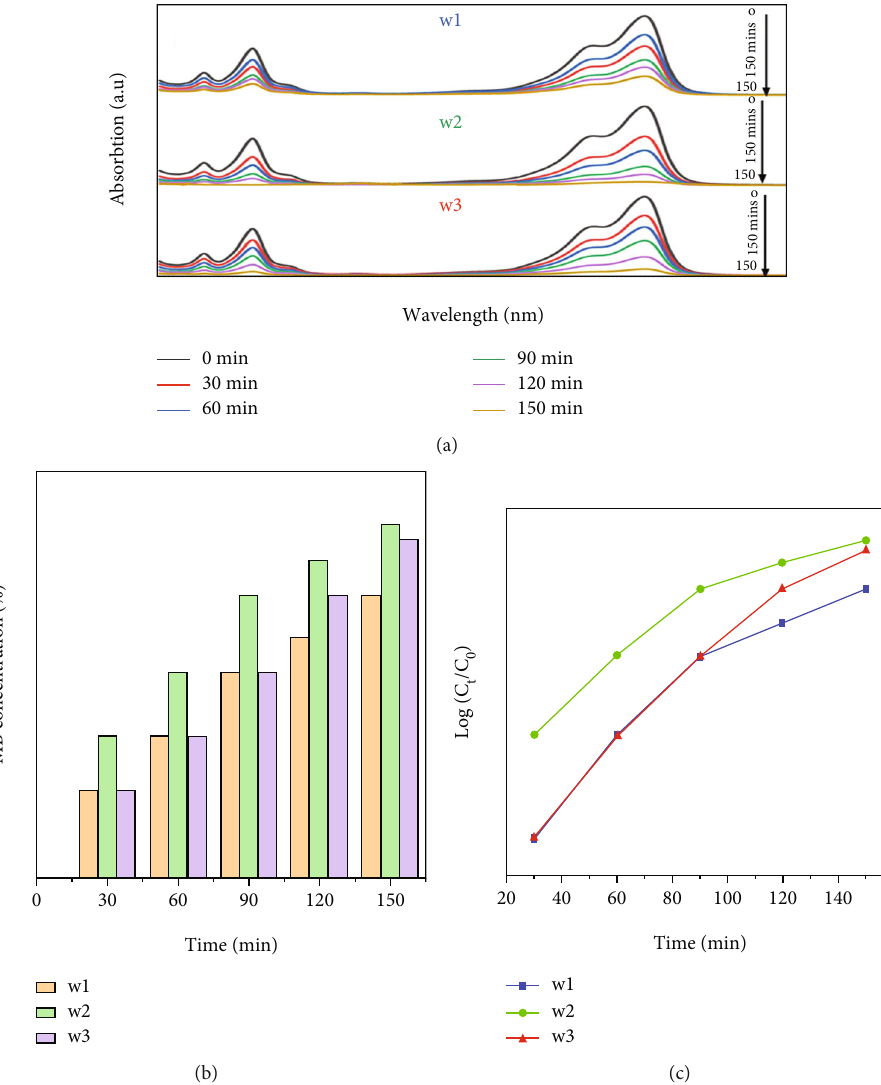
Figure 9: (a) UV-Vis spectra of methylene blue, (b) degradation concentration, and (c) kinetics study of WO